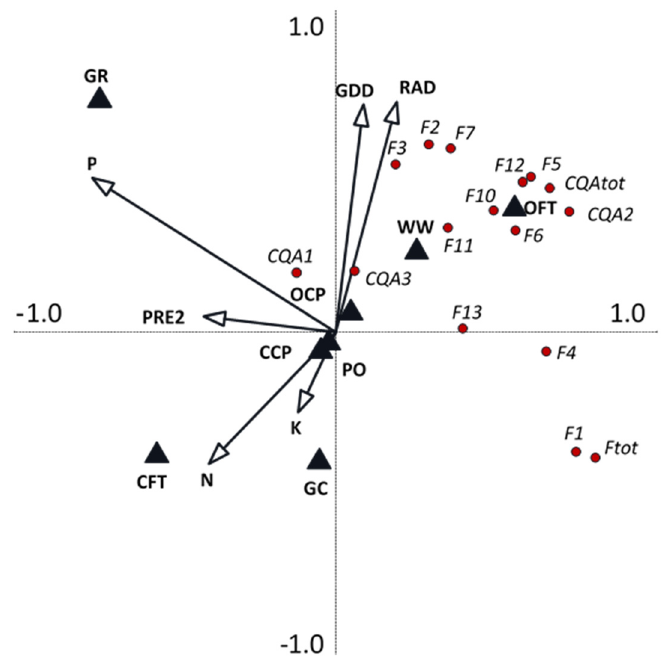
Figure 12 . Biplot derived from redundancy analysis showing the relationship between weather con- ditions (in the 14–15-week period before leaf samples were taken in 2005, 2007, 2008 and 2009), N, P and K availability (estimated from flag leaf N P and K content at growth stage 50 (GS50), and agronomic management explanatory variables/drivers and phenolic compounds in wheat leaves at GS50, data from [33]. Axis 1 explains 60% and axis 2 a further 18% of the variation. Continuous explanatory variables: N, N-availability ( p = 0.064); P, phosphorus availability ( p = 0.002); K, potas- sion availability ( p = 0.278); GDD, air temperature ( p = 0.0024); RAD, radiation ( p = 0.002); PRE2, precipitation (( p = 0.090). Fixed explanatory variables: CFT, conventional fertilization ( p = 0.002); OFT, organic fertilization ( p = 0.002); CCP, conventional crop protection ( p = 0.160), OCP, organic crop protection ( p = 0.160); GC, pre-crop grass-clover ley ( p = 0.004); GR, pre-crop rye-grass ley ( p = 0.920) PO, pre-crop potato ( p = 0.312), WW, pre-crop winter wheat ( p = undefined). Phenolic acid response variables : c1 to c3, different individual chlorogenic acid derivatives; f1 to f13, different individual flavonoids; CQA tot , total chlorogenic acid derivatives; F tot , total flavonoids